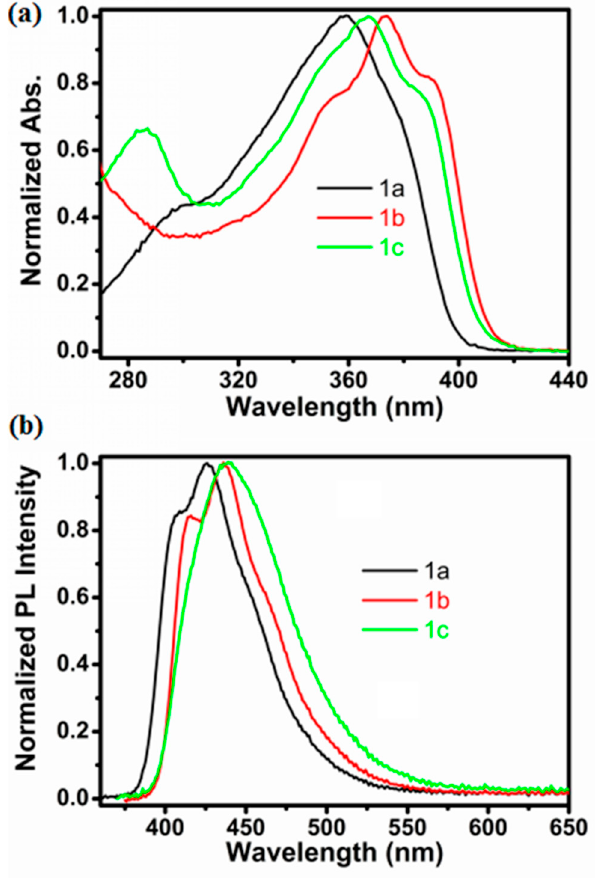
Figure 1. ( a ) Normalized absorption and ( b ) emission spectra of compounds 1a – 1c in DMSO solution ( λ ex = λ abs , 10 − 5 mol L − 1